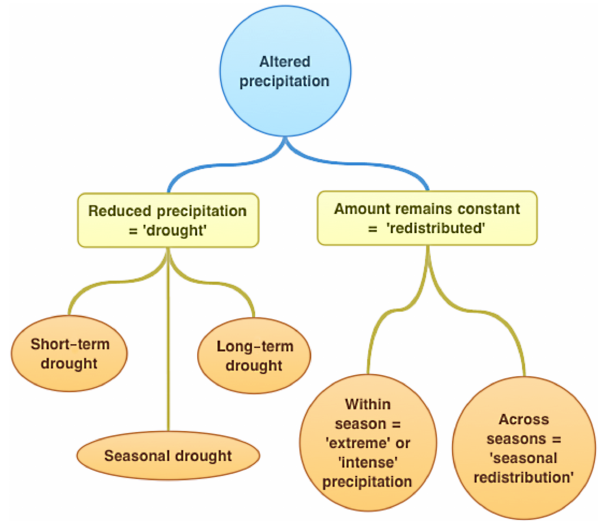
Figure 1. A schematic diagram explaining different types of altered precipitation. If the amount of precipitation is substantially reduced, this may be defined as “drought”. Descriptions of drought should include duration (e.g. short-term, long-term and seasonal drought) and also intensity (slight, moderate or severe), which will depend upon site conditions and species. If the amount of precipitation is not reduced, then this may be defined as “redistributed” precipi- tation, where the total amount of water remains constant but the amount of water and timing between watering events increase. Re- distributed precipitation may take place within a season, for exam- ple, a rainout shelter within a growing season (Fay et al., 2008), or within glasshouses over a three-month period. Redistributed precip- itation may also take place across seasons, where water is withheld during one season and supplementally reapplied in the following months/seasons. For further explanation of “extreme” precipitation events, see Smith